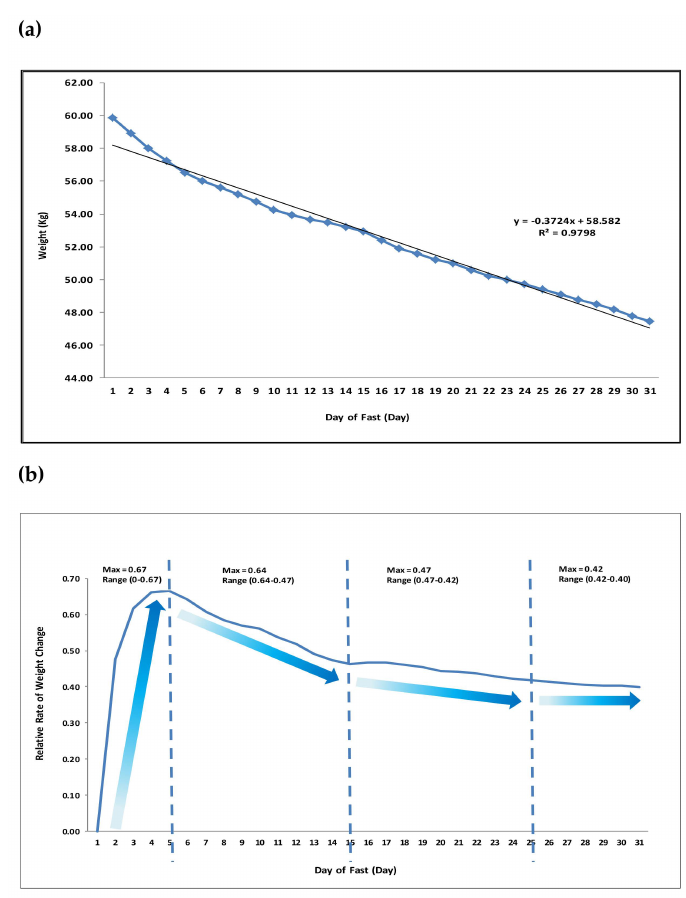
Figure 1. Time-dependent Changes in Weight during Prolonged Fasting (31 Days). Adapted from: Francis Gano Benedict: A study of Prolonged Fasting. ( a ), Daily Net Weight Loss: calculation of daily weight reduction in 31 days (D) of fasting. Initial weight was 59.86 kg at D1, final weight was 47.47 kg at D31, total weight loss − 12.4 kg. R 2 = 9798 indicated a linear relationship between time and net weight loss. ( b ) Changes in Rate of Daily Weight Loss: relative to starting rate of weight loss, rate of weight loss per day indicates various changes whereby a steep rate of weight loss we observed in the first five days of fasting (D1–5; Maximum Rate 0.67), followed by a slower rate of weight loss in the following 10 days (D5–15; Maximum Rate 0.64), which decreased further in the next 10 days (D15–25; Maximum Rate 0.47) before reaching a plateau in the last five days of the fasting month (D25–30; Maximum Rate